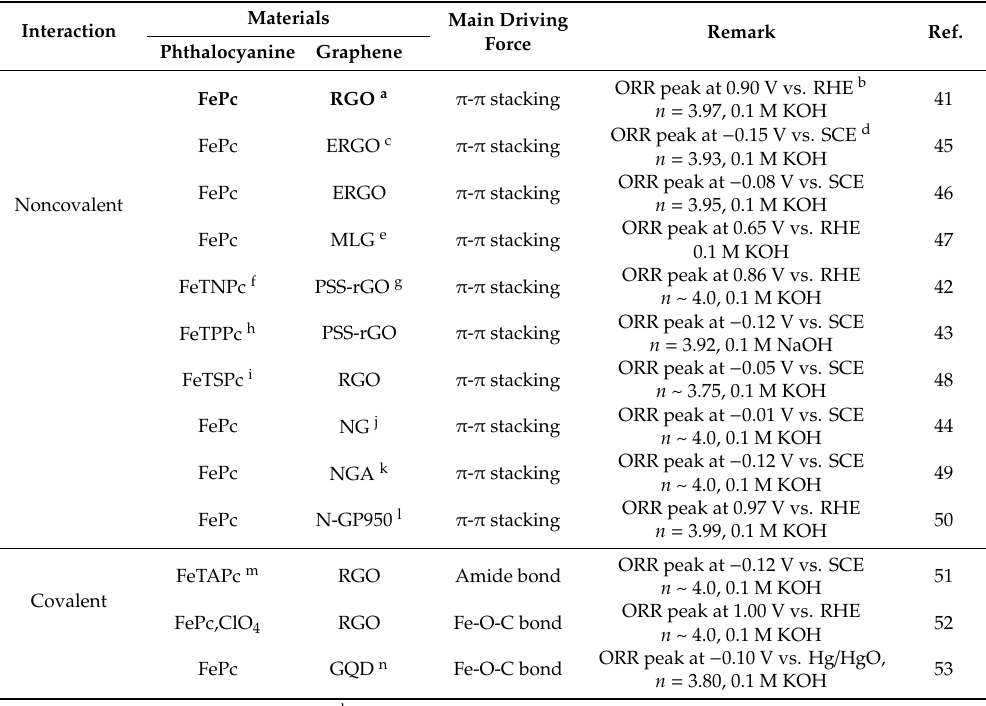
Table 1. Summary of FePc / graphene composite catalysts for the